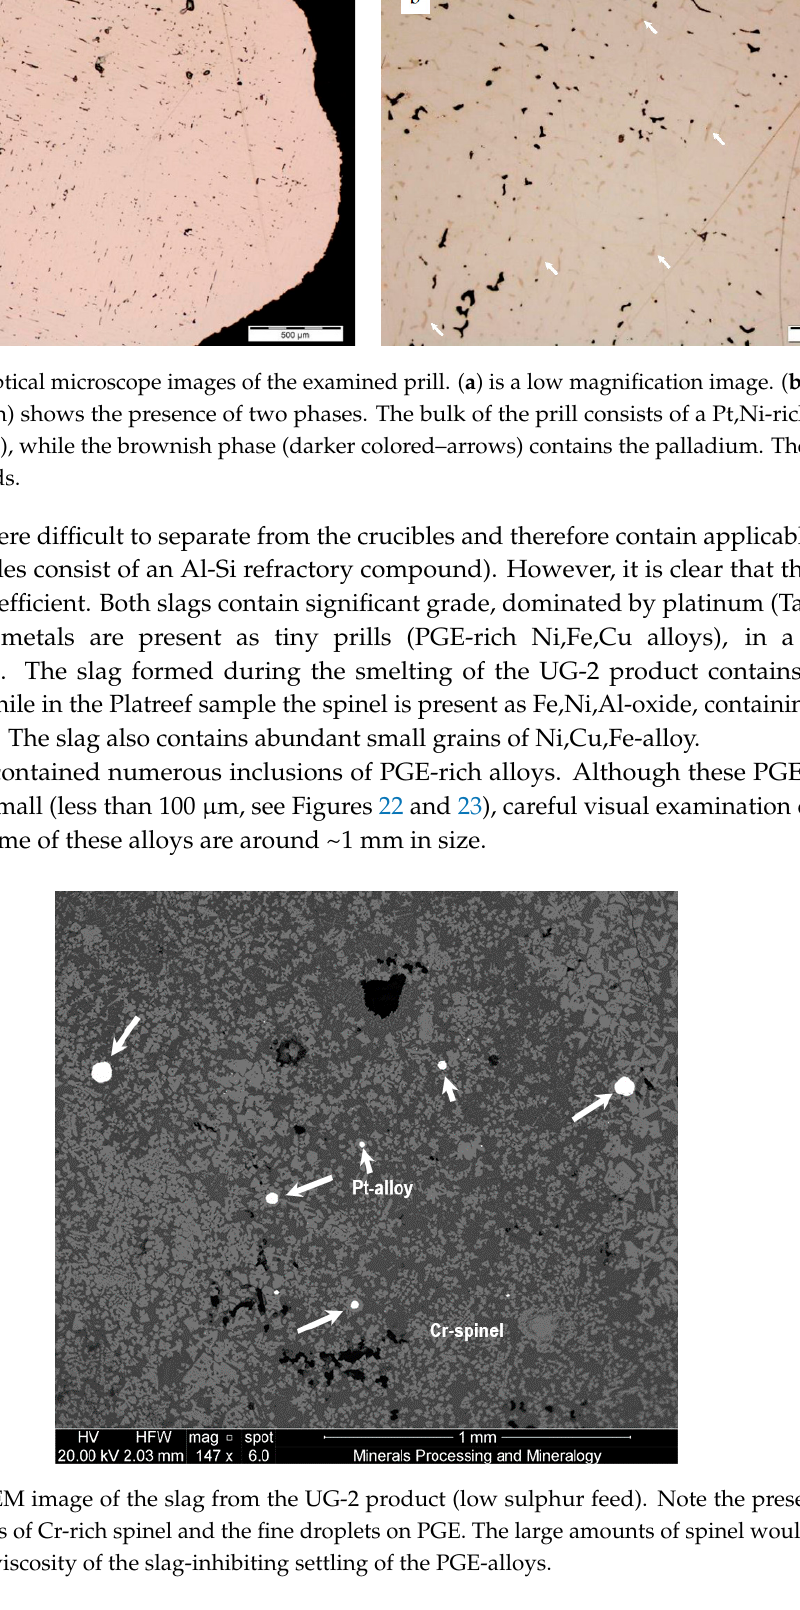
Table 7. Precious-metal and base-metal contents of 3 slag samples resulting from the smelting process. Note the variation in PGE contents. The Al content gives an indication of the amount of refractory included in the analysis (the crucible consists of an Al-Si compound).